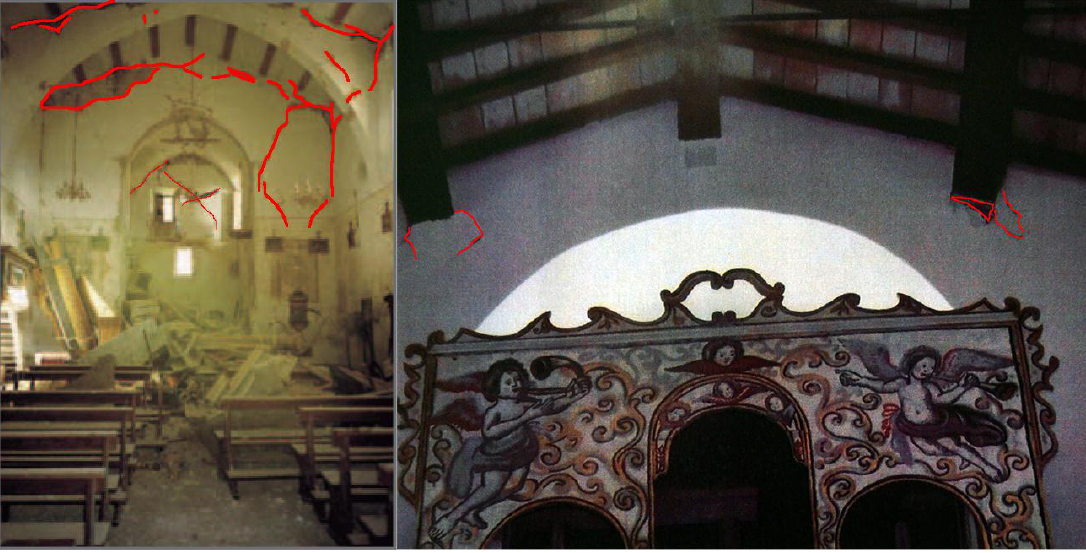
Figure 22. Comparison of the types of roof and the relative state of damage after the 1997 earthquake and the 2016 one.